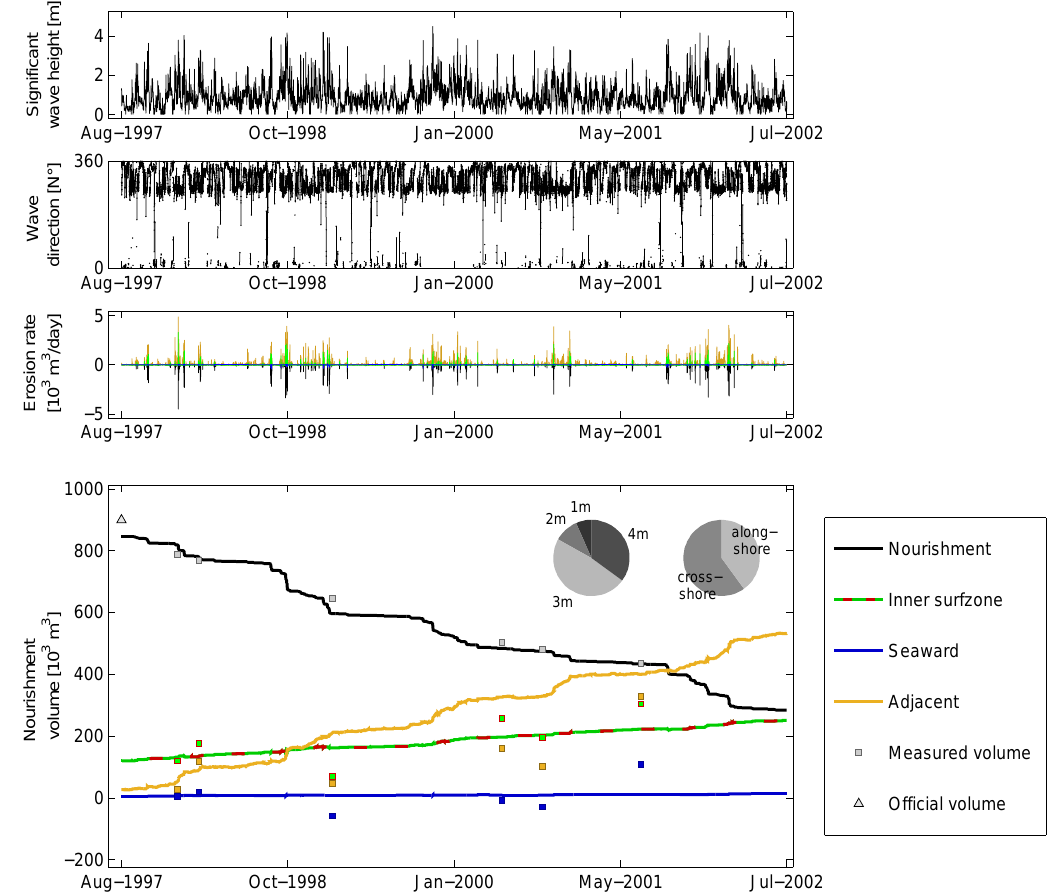
Figure 14. Modelled and observed volumetric change of the initial nourishment area of the Ter Heijde’97, Katwijk’98, Noordwijk’98, Noordwijkerhout’02 and Egmond’99 shoreface nourishments. Observations are shown with square markers. The relative contribution of wave height, wave incidence angle and cross-shore/alongshore erosion of the shoreface nourishment are shown in pie charts. Left pie chart: contribution of wave height classes. Right pie chart: contribution of cross-shore and alongshore transport to the total erosion of the